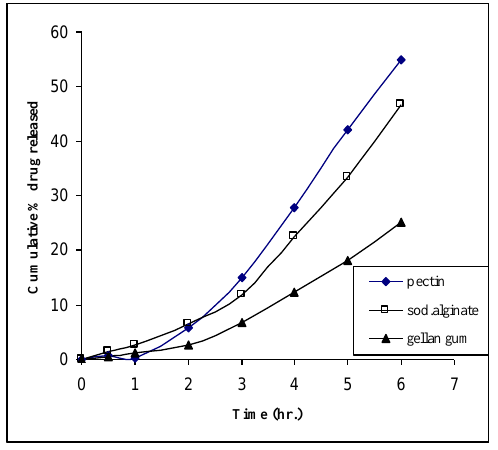
Figure (1): Cumulative in vitro release of naproxen (2.5% w/v) from 1% (w/v) concentrations of pectin, sodium alginate and gellan gum